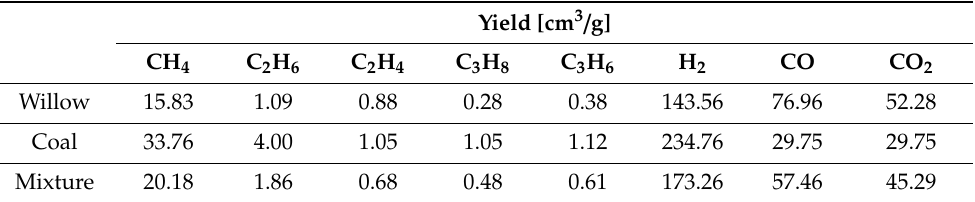
Figure 13. The rate of CH 4 , H 2 , C 2 H 6 and CO emissions during pyrolysis as a function of temperature [17,91]. Table 1. The yield of the pyrolysis gaseous products [17,91].